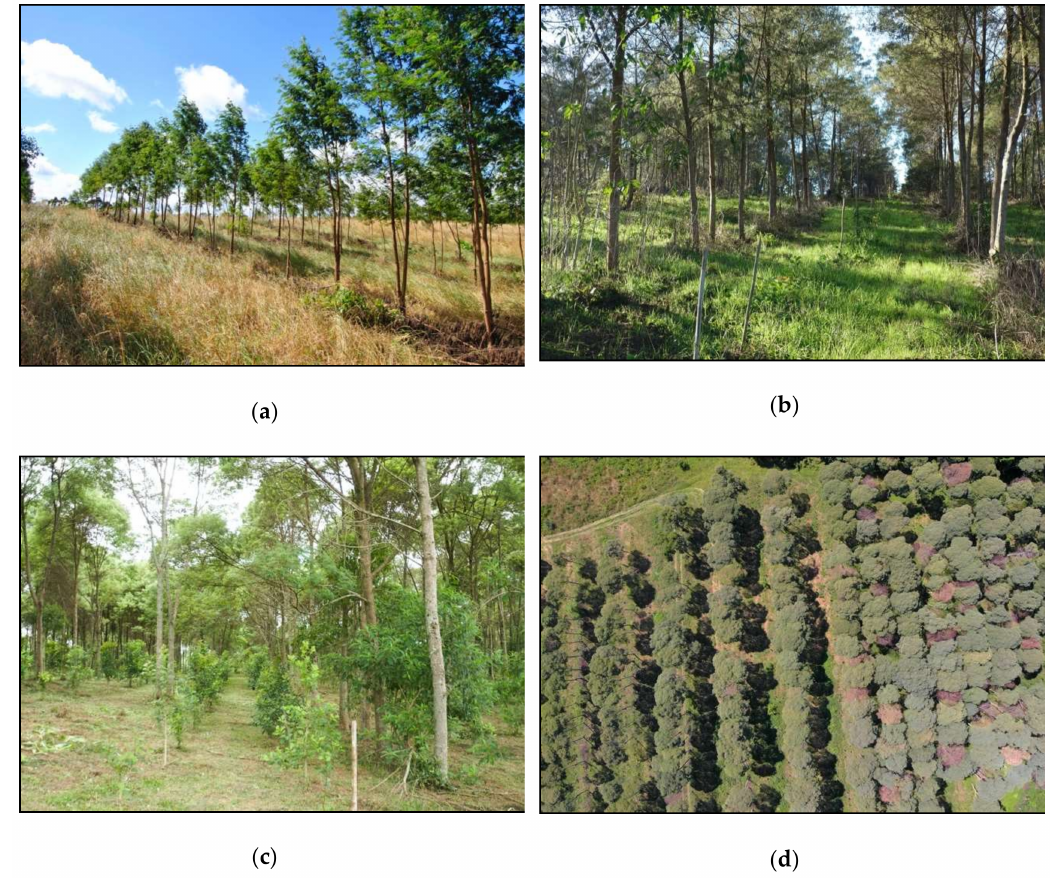
Figure 4. Productive Agroforestry Restoration carried out in a degraded agroecosystem: ( a ) initial planting of the fast-growing bracatinga for rapid canopy development (year 1); ( b ) developed canopy allowed for the plantation of erva-mate (year 3); ( c ) commercial maturity of erva-mate generates profitability for the system (year 8); ( d ) di ff erent methods of bracatinga harvesting: left—alternate full row removal for optimized financial return from lumber; right—in row-alternate tree girdling (trees with brown crowns) for subsequent harvesting to minimize environmental